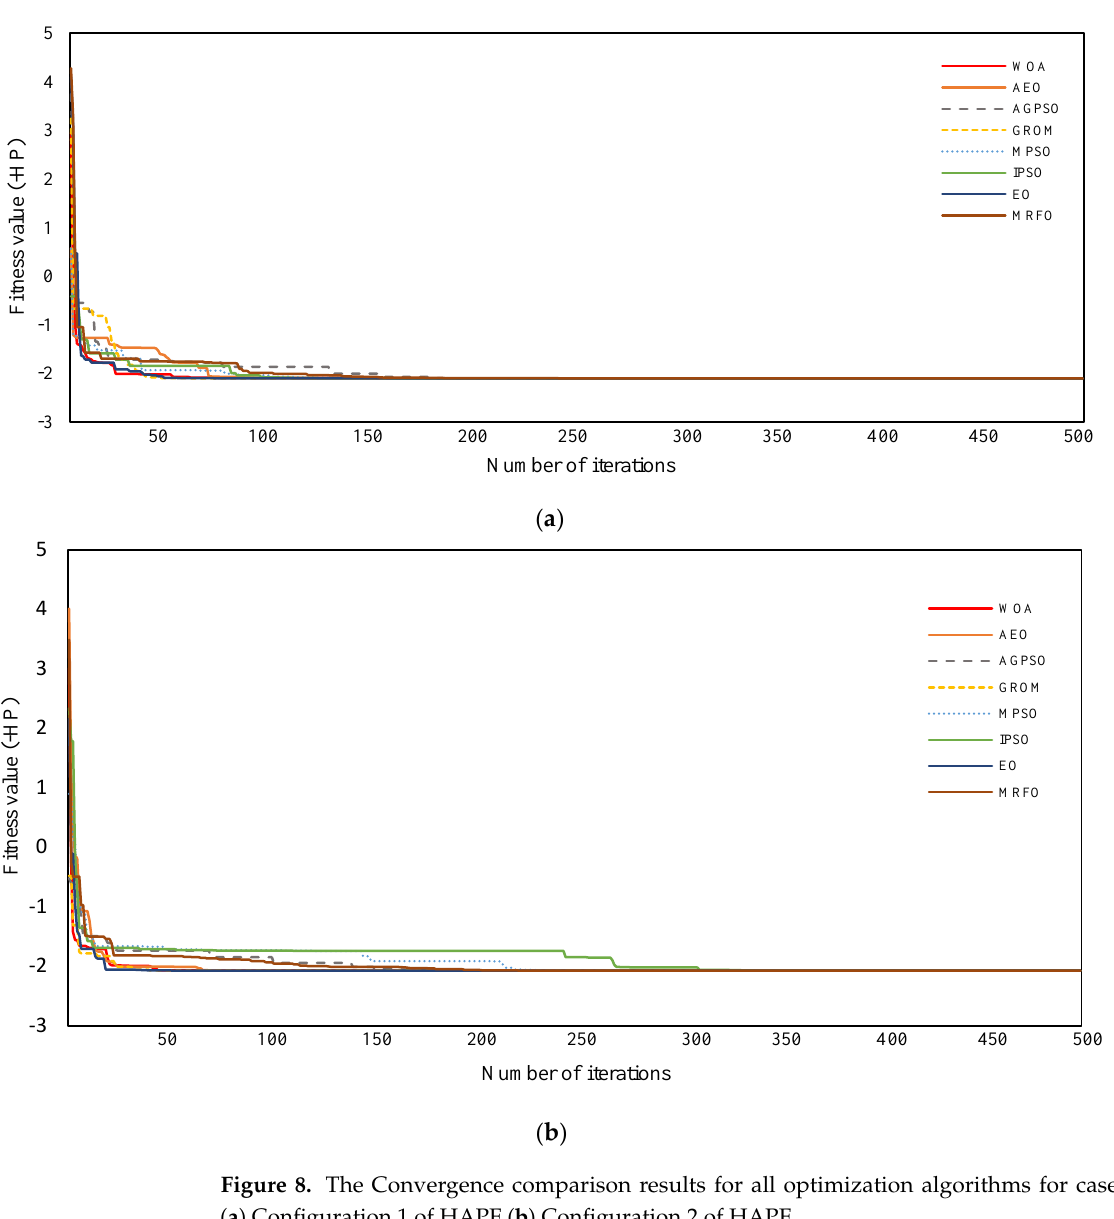
Figure 8. The Convergence comparison results for all optimization algorithms for case study 3 ( a ) Configuration 1 of HAPF ( b ) Configuration 2 of HAPF.